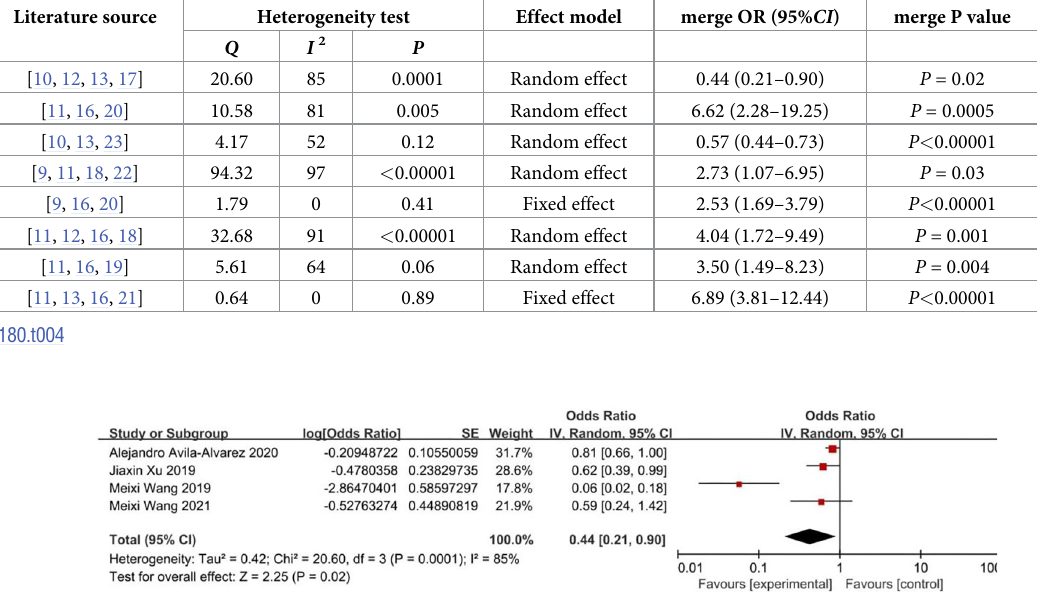
Fig 2. Forest diagram of the relationship between birth weight and the incidence of MBDP.